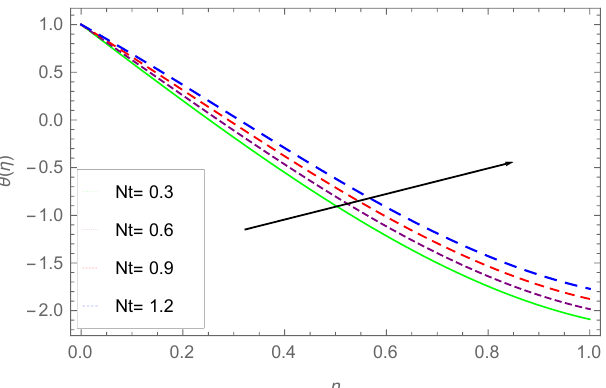
Figure 9. Impact of Nt on θ ( η ) , when Nb = 0.5, (cid:101) = 0.4, β = 1.0, S = 0.3, Sc = 0.6, Pr = 0.5.